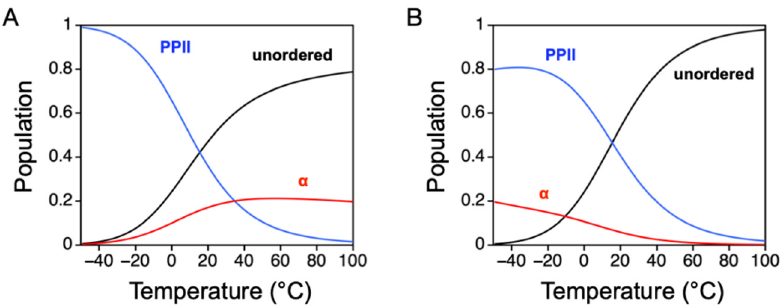
Figure 9. Temperature effects on PPII, α -helix, and unordered populations in an unfolded polypeptide. ( A ) Δ H PPII = 10 kcal mol − 1 and ∆ H α = 1 kcal mol − 1 . ( B ) Δ H PPII = 10 kcal mol − 1 and ∆ H α = 11